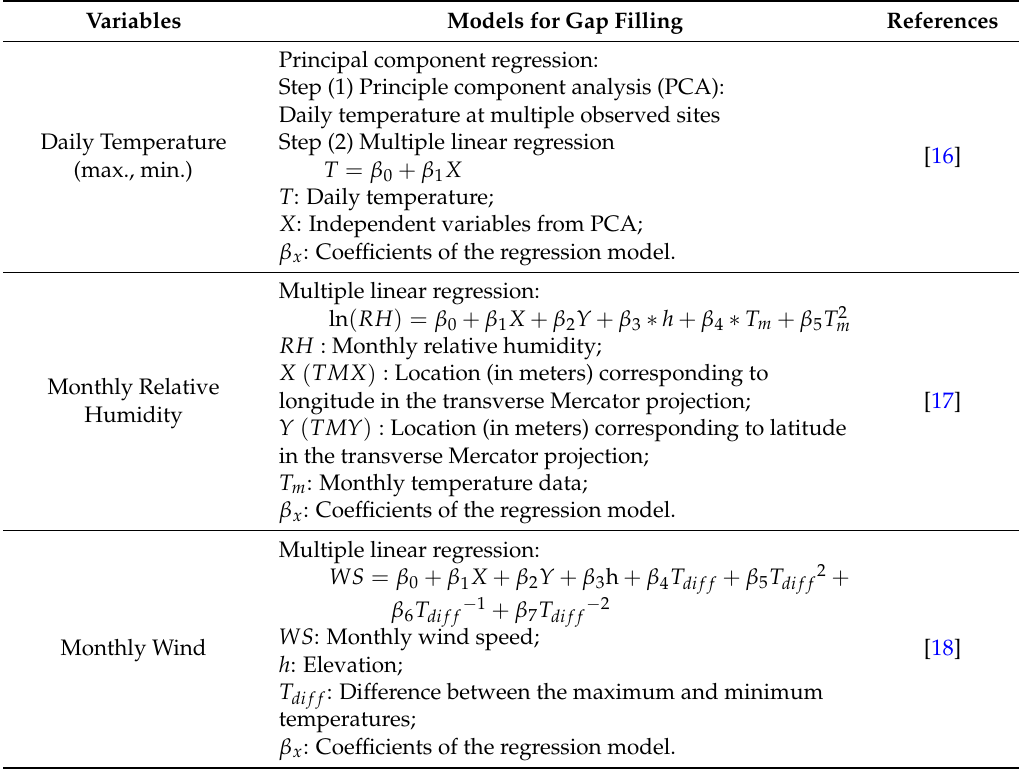
Table 1. Summary of models for temperature, relative humidity, and wind